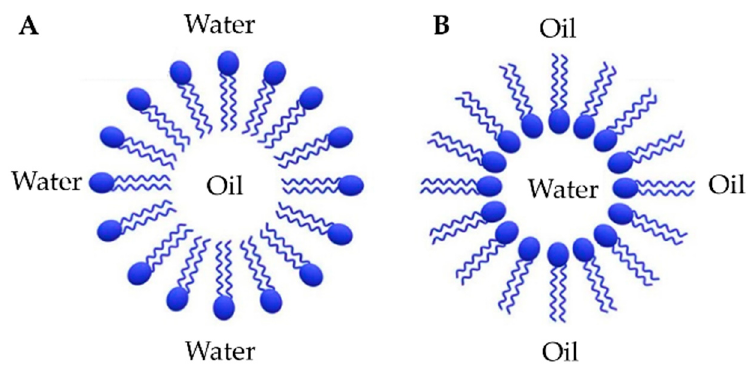
Figure 2. Schematic representation of ( A ) normal micelles and ( B ) inverted micelles. Adapted from [38] (published by MDPI), licensed under CC BY.